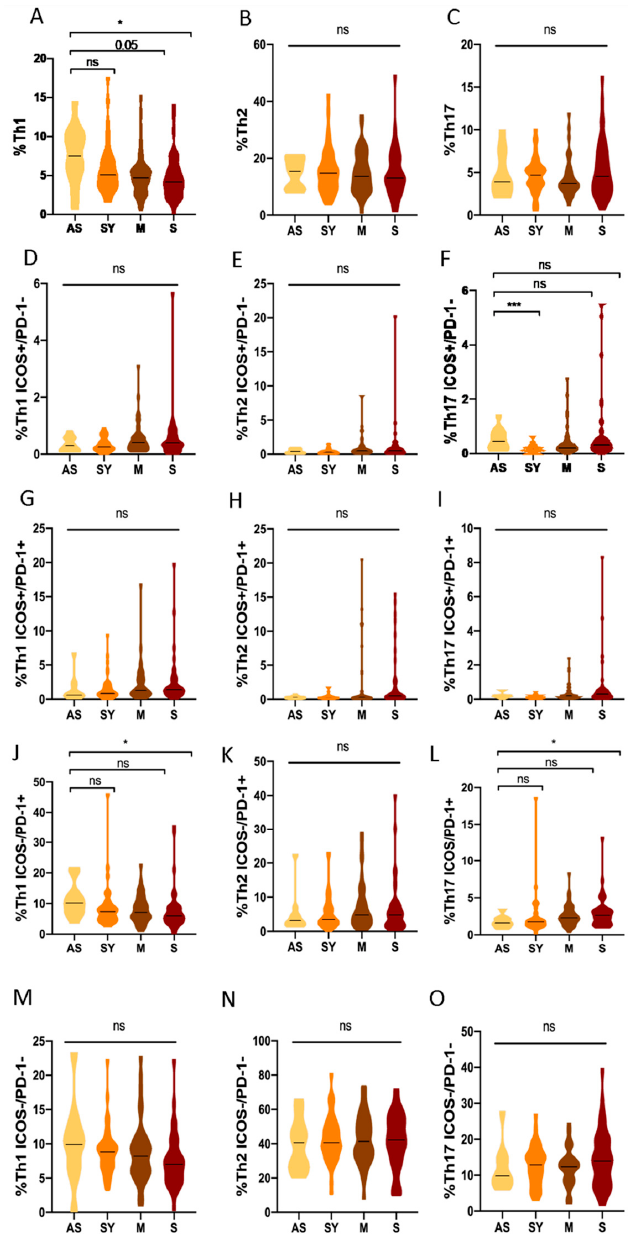
Figure 7. Th subsets: comparison of asymptomatic COVID-19 vs. symptomatic ones. ( A ) Total percentage of Th1 CD4+ T cells ( B ) Total parentage of Th2 CD4+ T cells ( C ) Total percentage of Th17 CD4+ T cells ( D ) Percentage of early-activated (ICOS+/PD-1-)Th1 CD4+ T cells ( E ) Percentage of early-activated (ICOS+/PD-1-)Th2 CD4+ T cells ( F ) Percentage of early-activated (ICOS+/PD-1-)Th17 CD4+ T cells ( G ) Percentage of late-activated (ICOS+/PD-1+)Th1 CD4+ T cells ( H ) Percentage of late-activated (ICOS+/PD-1+)Th2 CD4+ T cells ( I ) Percentage of late-activated (ICOS+/PD-1+)Th17 CD4+ T cells ( J ) Percentage of senescent (ICOS-/PD-1+)Th1 CD4+ T cells ( K ) Percentage of senescent (ICOS-/PD-1+)Th2 CD4+ T cells ( L ) Percentage of senescent (ICOS-/PD-1+)Th17 CD4+ T cells ( M ) Percentage of quiescent (ICOS-/PD-1-)Th1 CD4+ T cells ( N ) Percentage of quiescent (ICOS-/PD-1-)Th2 CD4+ T cells ( O ) Percentage of quiescent (ICOS-/PD-1-)Th17 CD4+ T cells. AS; asymptomatic COVID-19 patients, SY; symptomatic COVID-19 patients without hospitalization requirements, M; mild to moderate hospitalized COVID-19 patients and S; Severe COVID-19 patients. ns, not significant; * p < 0.05; ** p < 0.01.